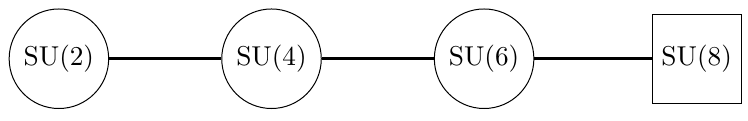
Figure 2 . Quiver for the theory UV completion of ( A 3 ; A 7